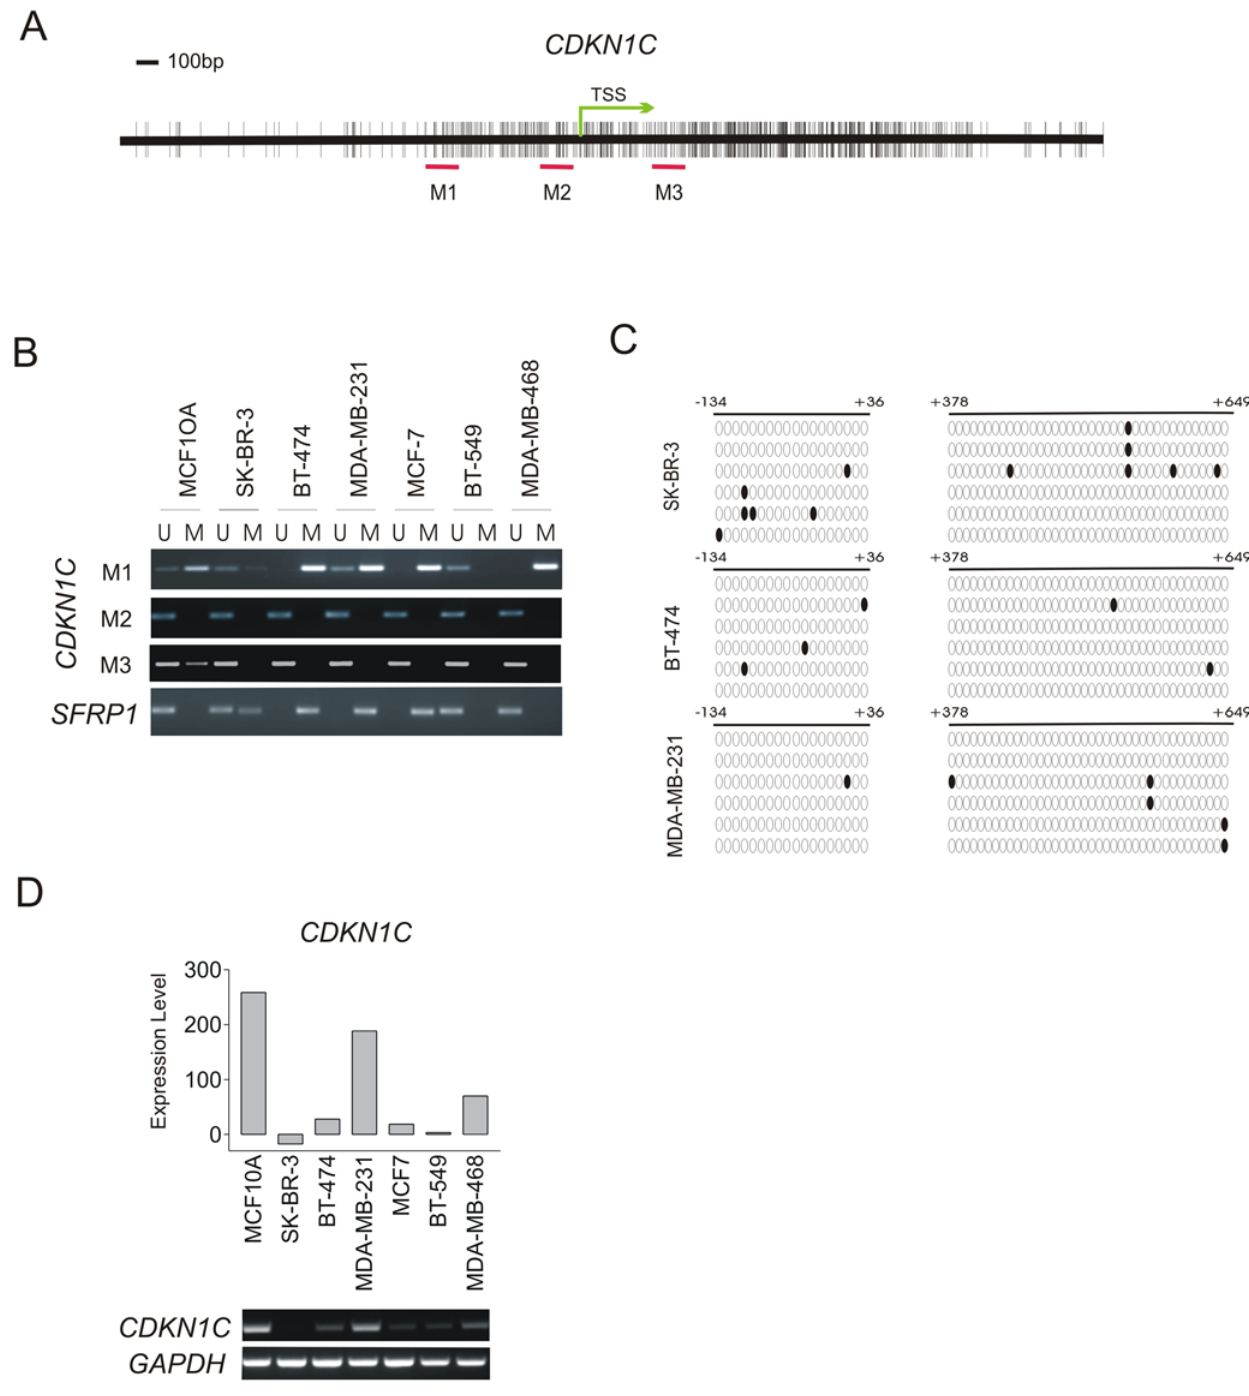
Figure 1. DNA methylation status of CDKN1C promoter in breast cancer cells. (A) Schematic representation of CDKN1C locus. Vertical bars indicate the CpG sites. TSS, transcription start site. M1, M2 and M3 represent genomic regions for methylation specific PCR (MSP) analysis. (B) MSP analysis of genomic regions surrounding the TSS of CDKN1C . SFRP1 was used as a positive control of effective bisulfite conversation. (C) Bisulfite genomic DNA sequencing results of indicated regions in SK-BR-3, BT-474 and MDA-MB-231 cells. (D) Upper panel, expression values of CDKN1C in Illumina expression data of breast cancer cell lines. Lower panel, expression of CDKN1C in indicated cell lines are determined by RT-PCR. doi:10.1371/journal.pone.0005011.g001 included for the expression analysis. The results indicate that the TSA/Aza, did not give rise to such a strong induction (Figure 3A). As a marked contrast to CDKN1C , other CDKI family members combination of DZNep with TSA resulted in a robust induction of CDKN1C expression in SK-BR-3 cells, whereas the single drug did not respond to a similar extent, revealing the sensitivity of CDKN1C to this combination treatment (Figure 3A). Moreover, in treatment or other drug combinations, such as DZNep/Aza or